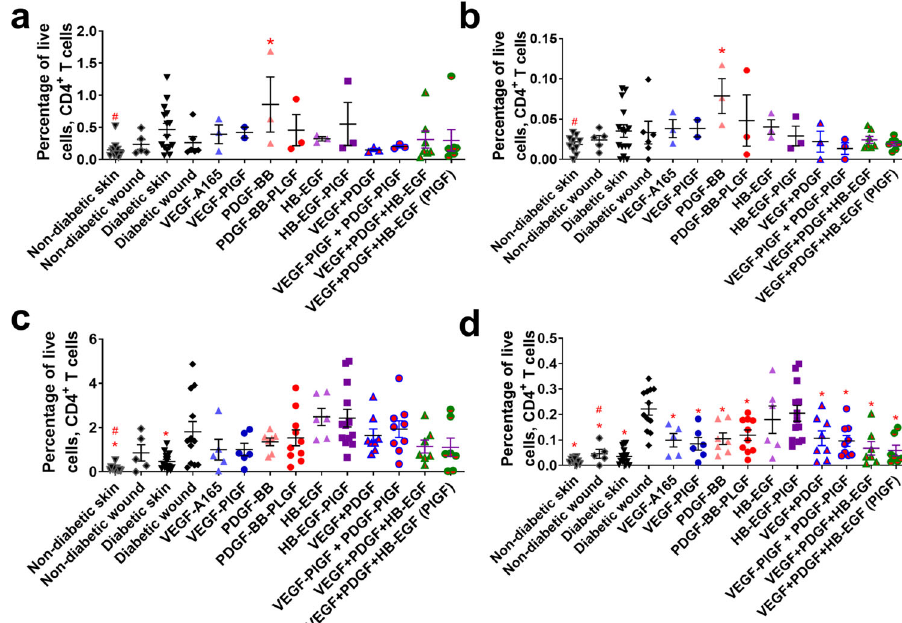
Fig. 6 CD4 + T cell count in wounds after 3 – 7 days of healing. CD4 + T cells (CD45 + , CD3 + , CD4 + ) at ( a ) 3 days or ( c ) 7 days. Subset of CD4 + T cells that are amphiregulin positive at ( b ) 3 days or ( d ) 7 days. Comparison includes unwounded skin from both the NOD and NOR mice. n ranges from 3 to 20. * Denotes comparison to the diabetic wound. # Denotes a comparison between untreated NOD wound and untreated NOR wound, and the WT GF(s) are compared to their counterpart -PLGF-2 123 – 144 variant(s), e.g., VEGF vs VEGF- PlGF-2 123 – 144 . * p < 0.05, p < 0.01, p < 0.001, Kruskal-Wallis + Mann-Whitney post hoc test. # p < 0.05, p < 0.01, p < 0.001, Mann-Whitney. Error bars are